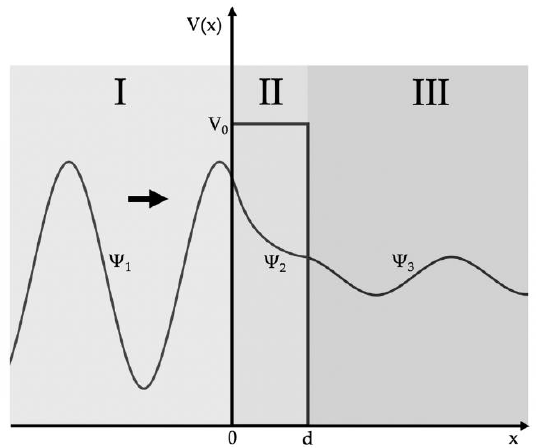
Figure 1. A wave arriving from the left hits a potential barrier. A part of the wave is reflected, and another part is transmitted through the barrier.